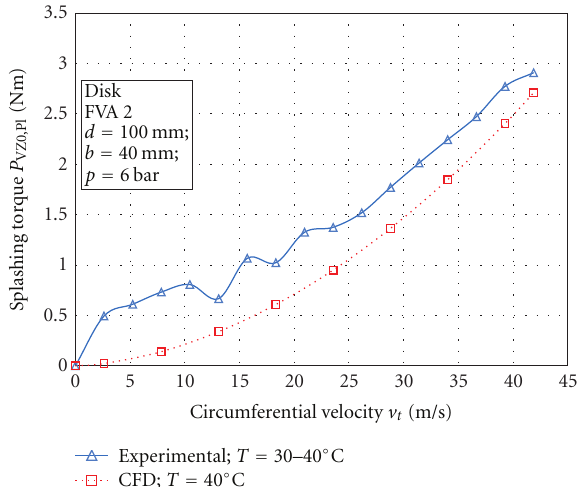
Figure 6: Results in terms of resistant torque versus circumferential velocity for the